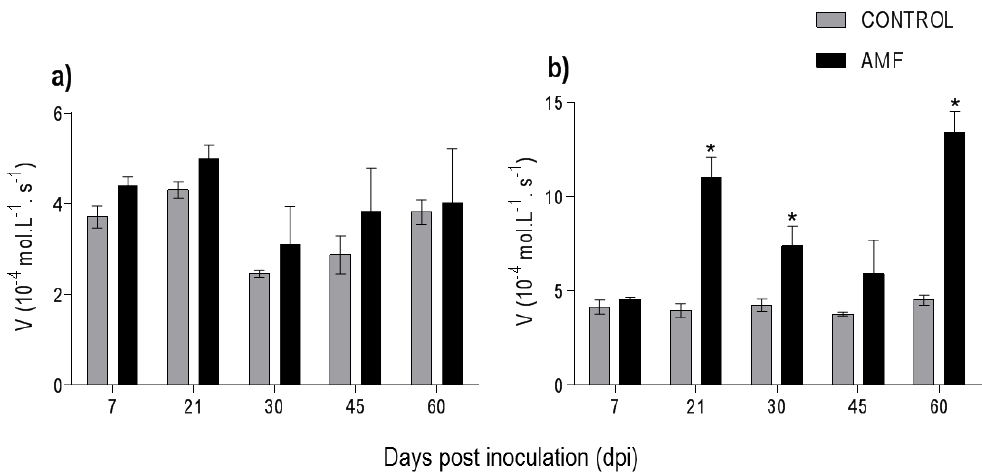
Figure 4. Activity of lipoxygenase in Piper nigrum L. (a) leaves and (b) roots. Asterisks on the bars represent statistically significant differences between the treatment and control groups, at the 5% probability level, by Bonferroni.